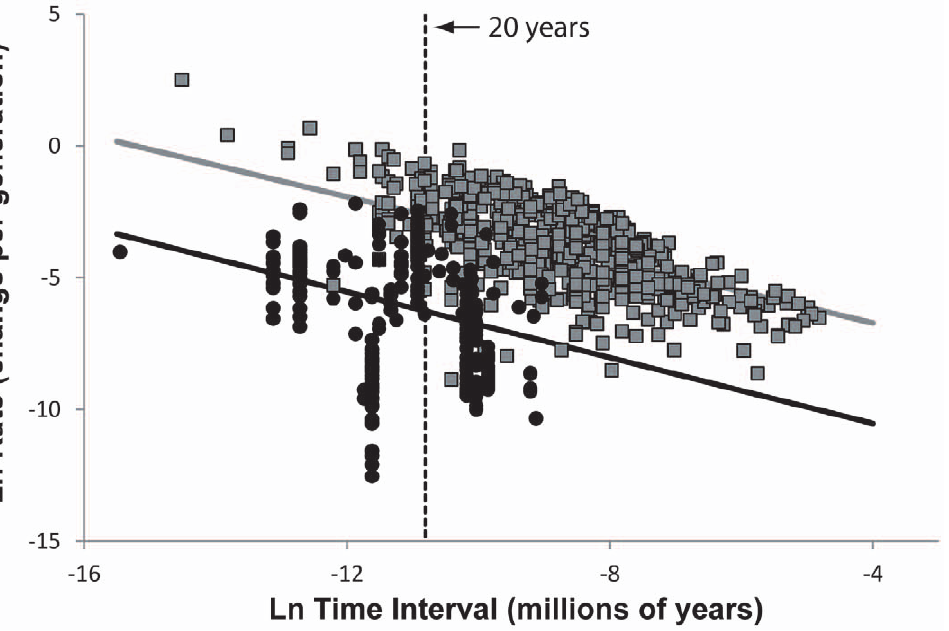
Figure 4. Biological rates and cultural rates calculated as change per generation. Biological rates (black circles) and cultural rates (gray squares), calculated as change per generation, are inversely correlated to the interval of the time over which the rates are measured. The solid lines represent the linear mixed model of interaction that best fit the biological (black line) and cultural (gray line) distributions (Table 5). The conversion of rates from an absolute time scale to a generational time scale impacts mostly the biological rates from species with a short generation time. For any given amount of phenotypic change observed over any given time interval, the difference between rate of change per millions of years and rates of change per generation time increases as generation time of species increases. This effect explains why the difference between the slopes of the two linear models, although significant, is smaller (Table 5) than that shown in Figure 2.